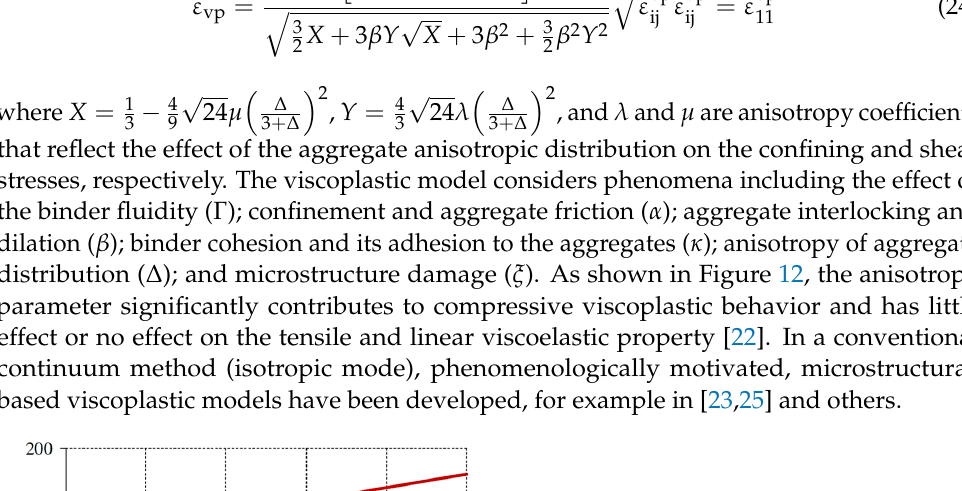
Figure 13. Digital image analysis process for microstructure modeling.